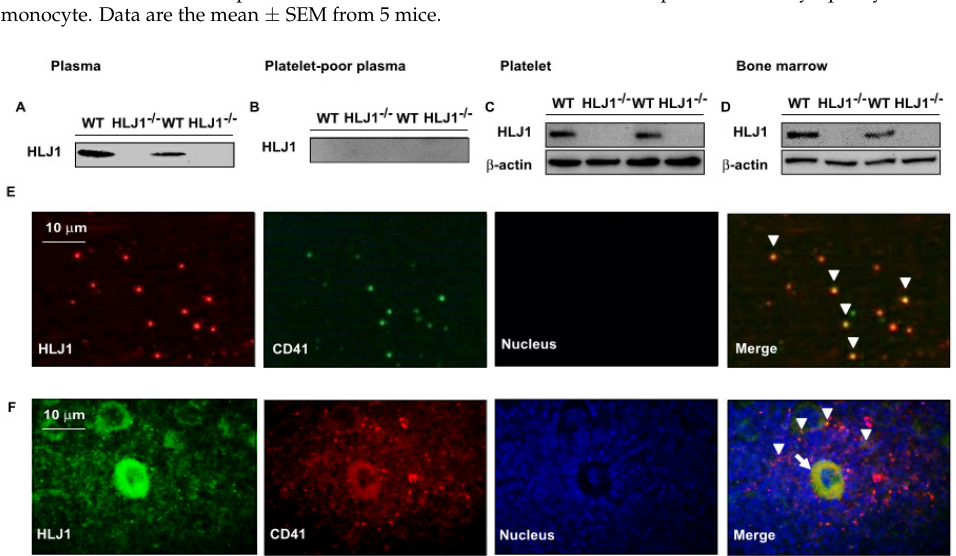
Table 2. Peripheral blood counts of WT and HLJ1 -/- mice.